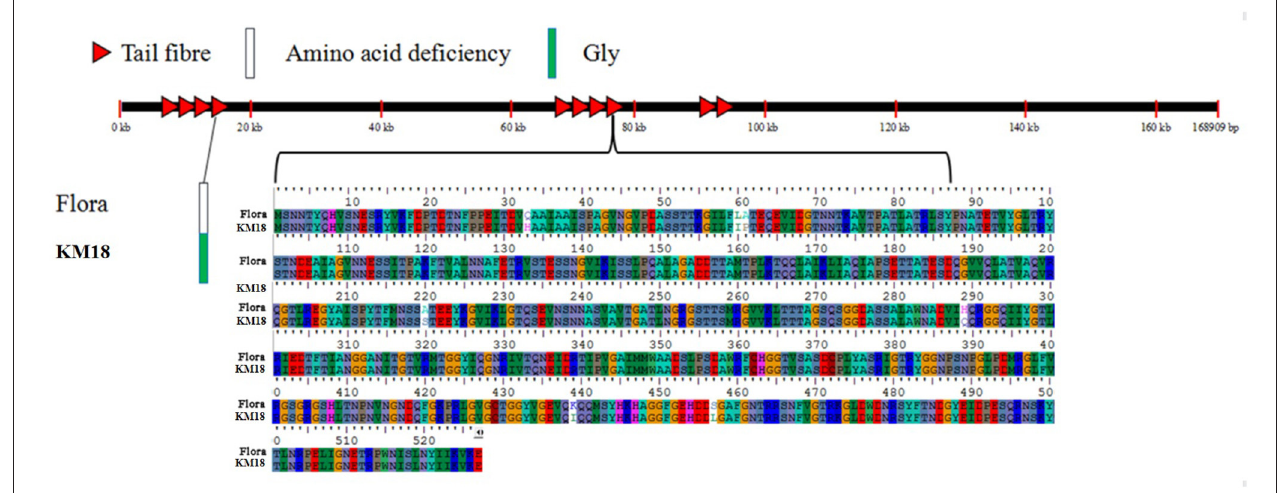
FIGURE 6 | Location of mutated bases and amino acids in the E. coli phage tail fiber proteins of the Flora and KM18 genomes. There are eight base mutations in the whole genome tail fiber; these positions are 322(-/G) of the fourth tail fiber and 33(G/A), 60(A/G), 61(A/G), 220(A/G), 289(A/G), 439(A/G), and 457(A/G) of the eighth tail